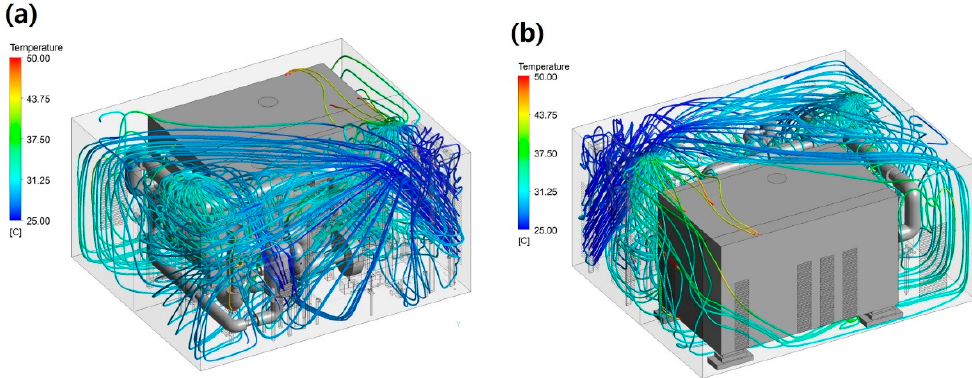
Figure 8. Path lines of inlet flows from louvers and outlet flows to the exit holes on the ceiling ( a ) frontal view and ( b ) backside view.